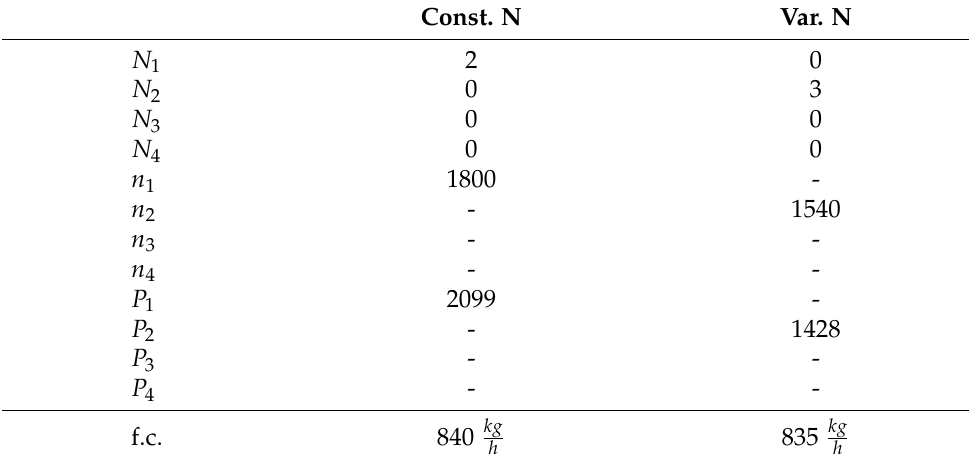
Table 5. Optimal solutions at design condition of 17 Kn. Const. N Var. N